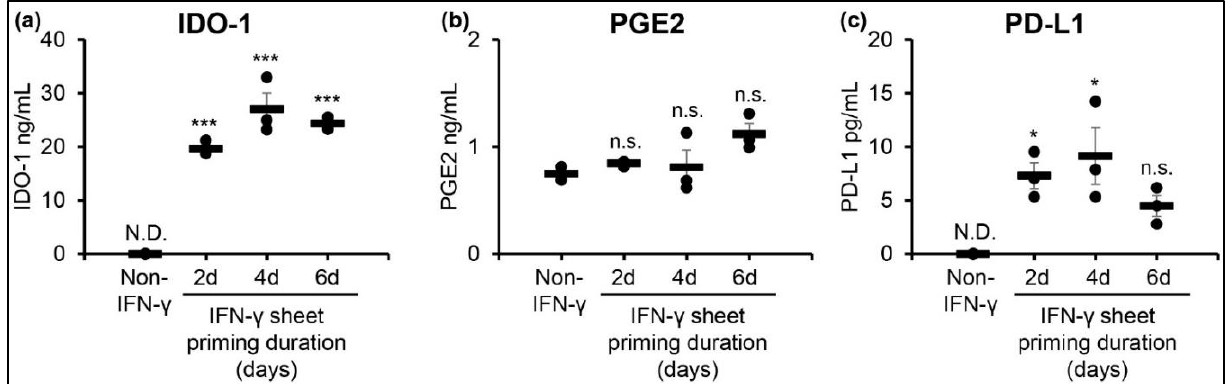
Figure 3. IFN- γ primed hcBMSC sheets exhibit upregulated cytokine secretion 4 days post IFN- γ removal. Enhanced levels of ( a ) IDO-1, ( b ) PGE2, and ( c ) PD-L1 secretion from IFN- γ -hcBMSC sheets was detected 4 days after removing the IFN- γ stimulation. Error bars represent means ± SE ( n = 3, independent experiments) (n.s. p ≥ 0.05, * p < 0.05, *** p < 0.001) Statistical analysis p values are compared to non-IFN- γ hcBMSC sheets ( non-IFN- γ, c ontrol).